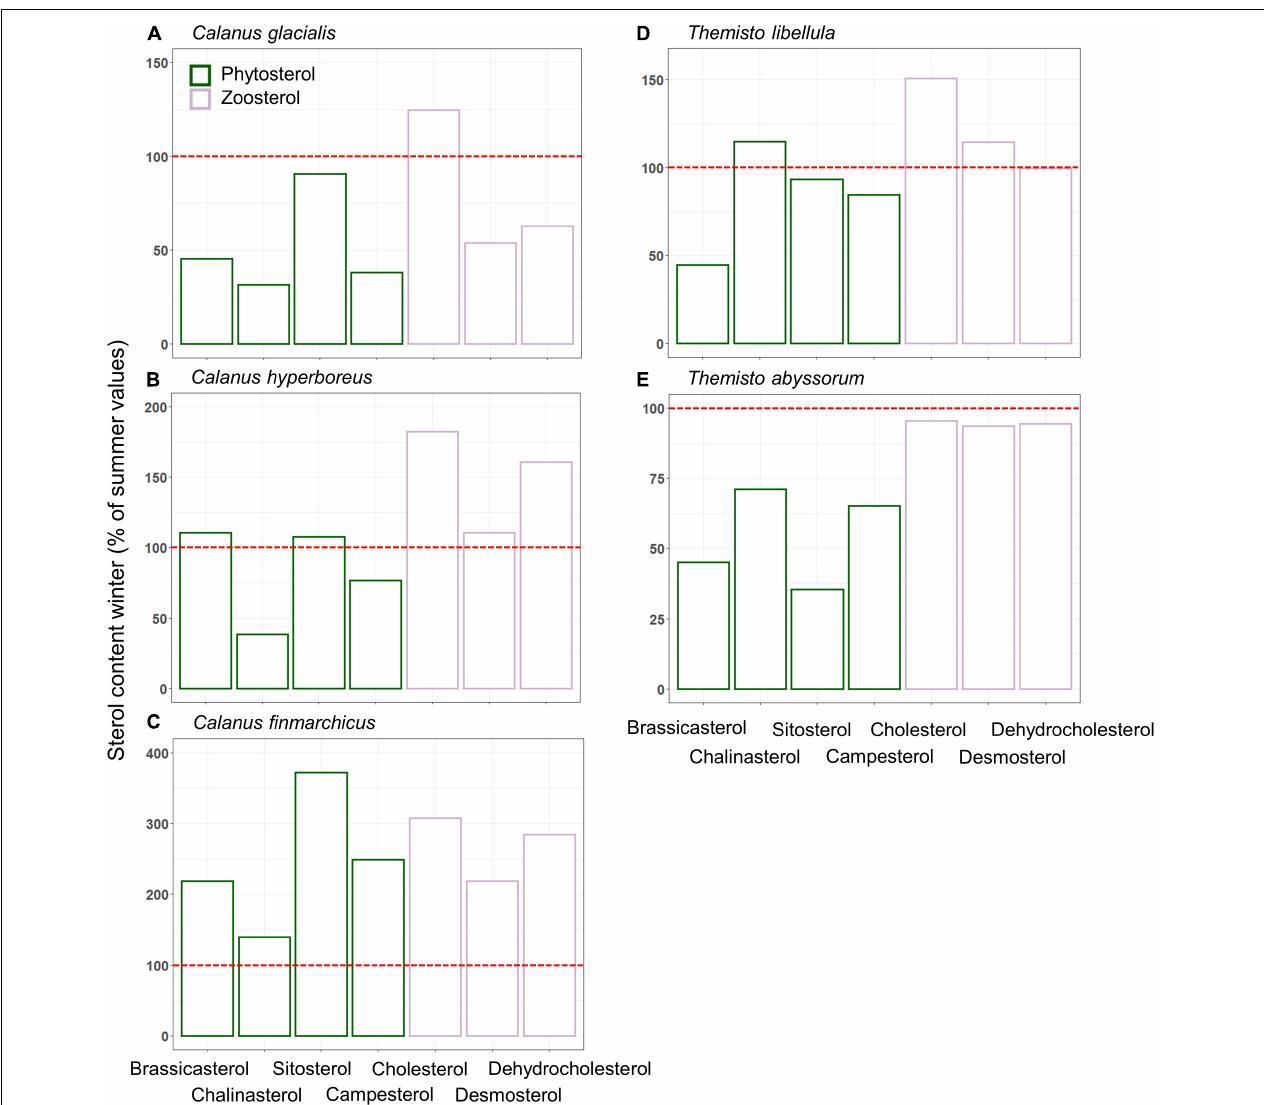
FIGURE 6 | Relative proportions of phyto-and zoosterols (mean ± SD%) represented by green and purple bars, respectively, during winter (Q4) related to summer (Q3) in Calanus spp. (A–C) and Themisto spp. (D,E) . Percentages are based on average sterol-content values from both sampling campaigns. The red line highlights 100%, i.e., same proportions of sterols during summer and winter. Sample size is presented in Table 4